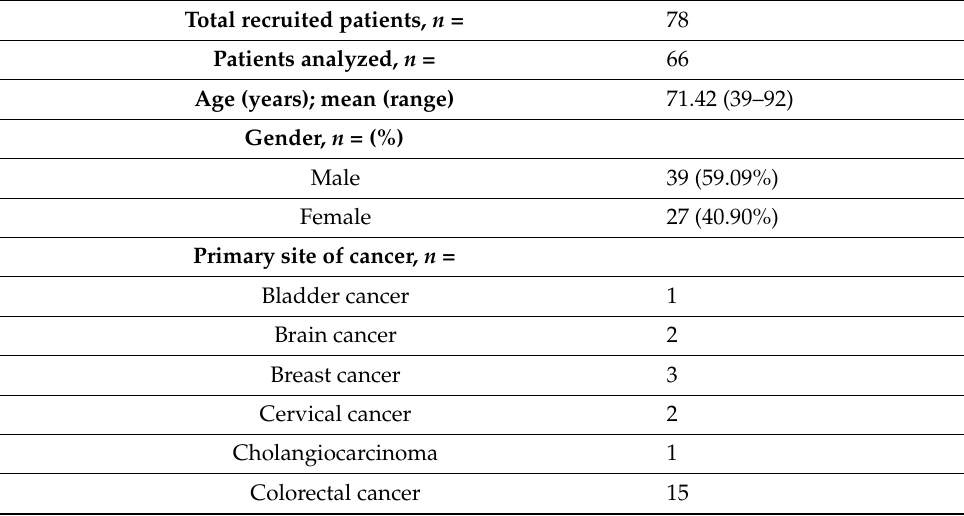
Table 1. Characteristics of recruited